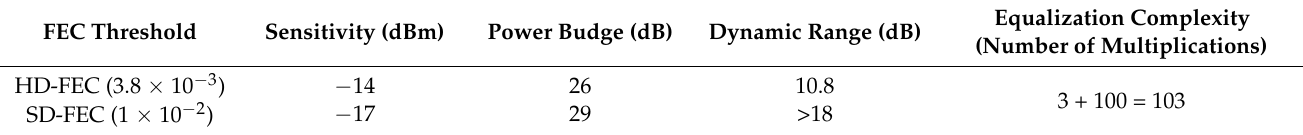
Table 2. 25 km downstream transmission with 3-symbol LUT and 100-tap FFE.